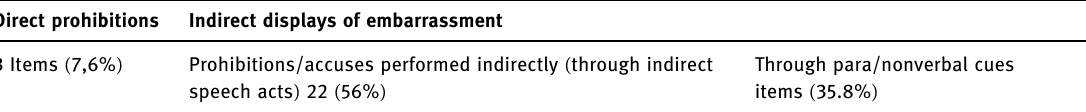
Table 2: Embarrassment for others/ashaming others – quanti fi cation of displays Direct